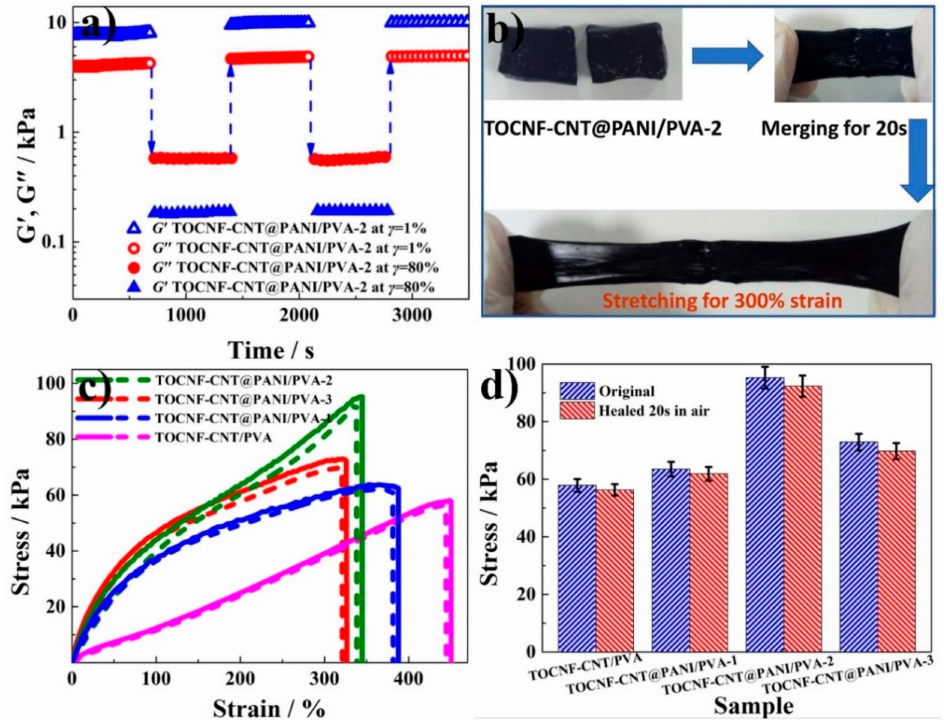
Figure 5. ( a ) The storage modulus ( G (cid:48) ) and loss modulus ( G” ) dependence of time in continuous step strain measurements. ( b ) Illustration of self-healing property for TOCNF-CNT@PANI / PVA-2 hydrogel. ( c ) Hydrogel stretching curve before and after 20 s self-healing. The solid lines represent the original hydrogels, and the dashed lines represent the self-healed hydrogels. ( d ) Histogram of tensile stress